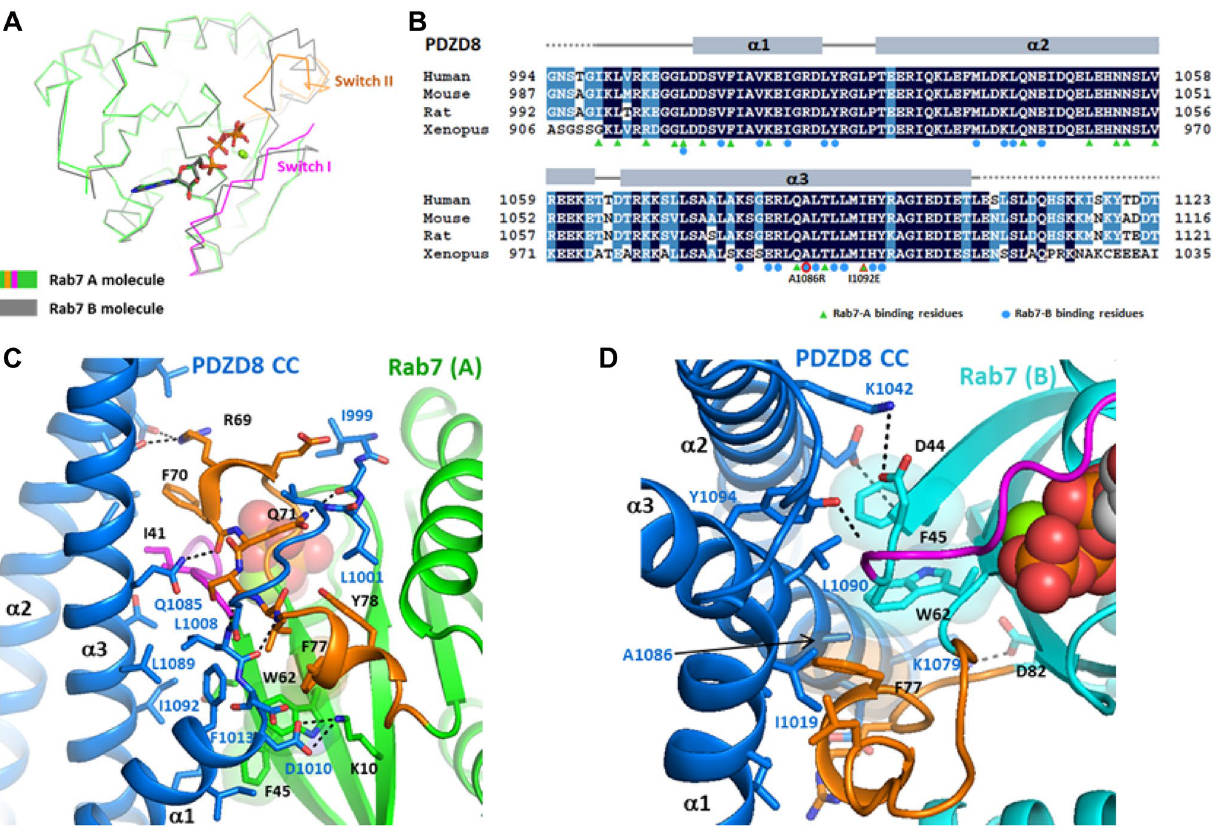
Figure 2. The binding interface of PDZD8 CC and Rab7. ( A ) Structural comparison of Rab7-A and Rab7-B. ( B ) The secondary structure elements of the PDZD8 CC domain. The PDZD8 residues contacting with Rab7 were indicated with green triangles for Rab7-A and blue circles for Rab7-B. The disordered residues in PDZD8 were indicated with dotted lines. The three PDZD8 residues mutated for the binding experiments were indicated with the red outlines. ( C ) The binding interface between the PDZD8 CC and Rab7-A. The residues forming the interface are shown in stick models. The hydrogen bonds are shown in dashed lines. The side chains